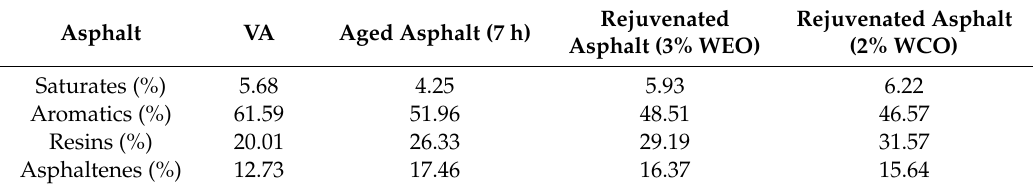
Table 5. Four components of VA, aged asphalts, and rejuvenated